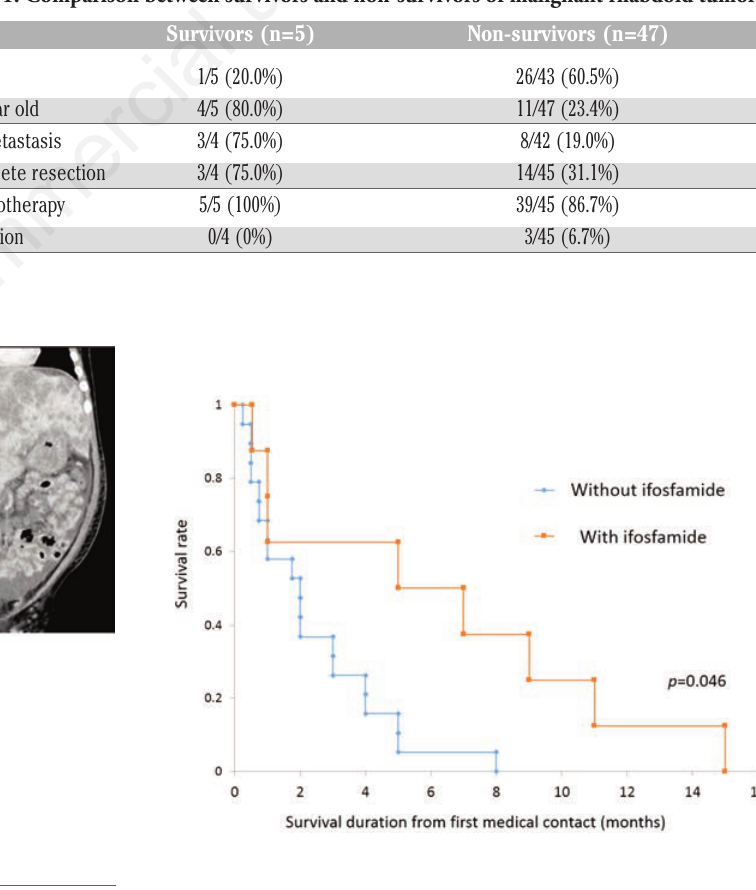
Figure 2. Survival curves for non-survivors treated by chemotherapy with/without